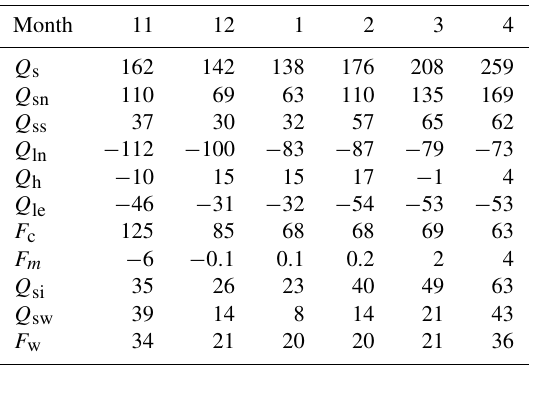
Table 3. The monthly means of heat fluxes (in Wm − 2 ) within the air–ice–water column. Q s : incident solar radiation; Q sn : net solar radiation; Q ss : net solar radiation for surface heat balance; Q ln : net long-wave radiation; Q h : sensible heat flux; Q le : latent heat flux; F c : surface conductive heat flux; F m : net surface heat flux, that is, the sum of Q ss , Q ln , Q h , Q le and F c ; Q si : solar radiation absorp- tion within the ice interior; Q sw : solar radiation into under-ice wa- ter; F w : heat flux from water into ice.